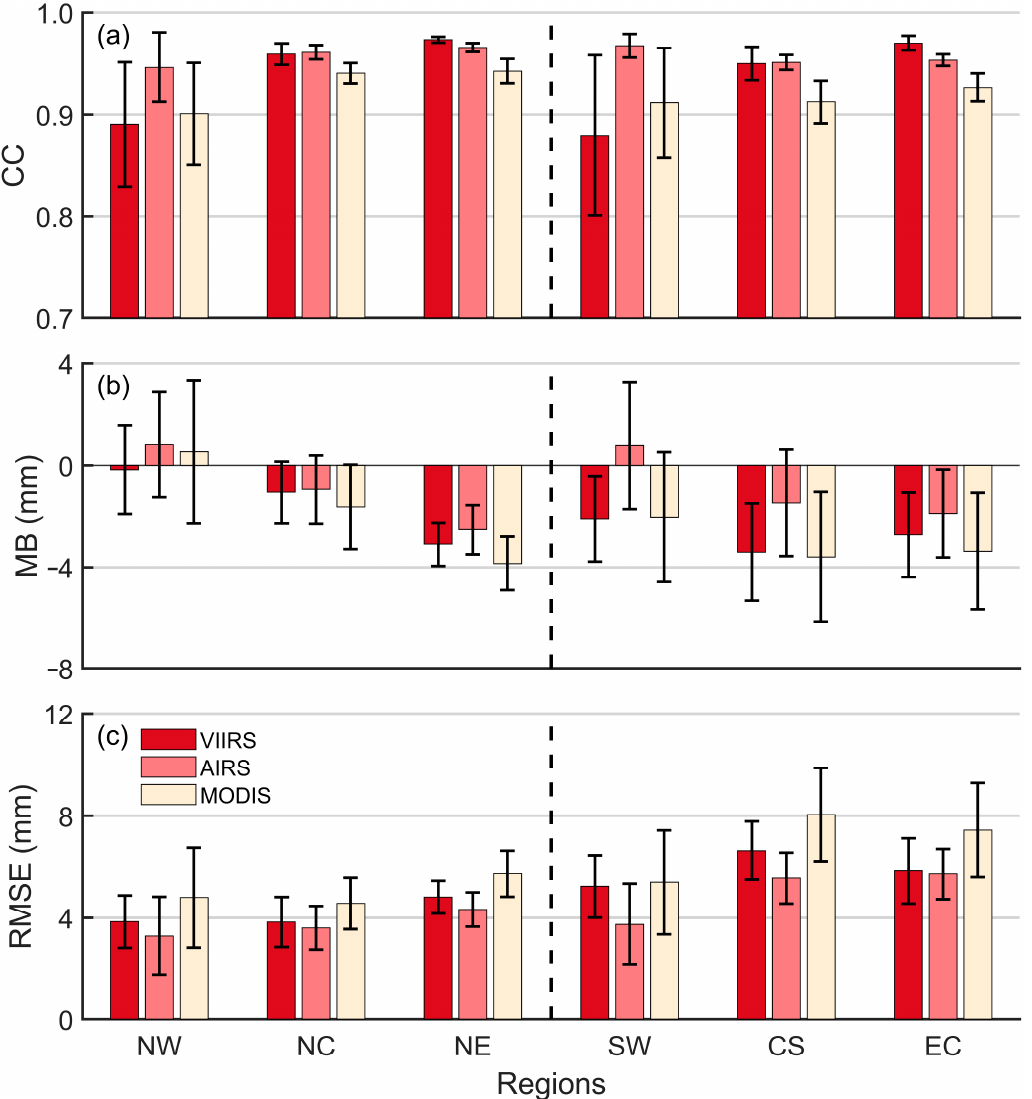
Figure 8. The mean values and standard deviations of three evaluation metrics (i.e., the CC ( a ), the MB ( b ), and the RMSE ( c )) of the PWV data derived from the remotely sensed water vapor products compared with the GPS-PWV within various regions of mainland China.